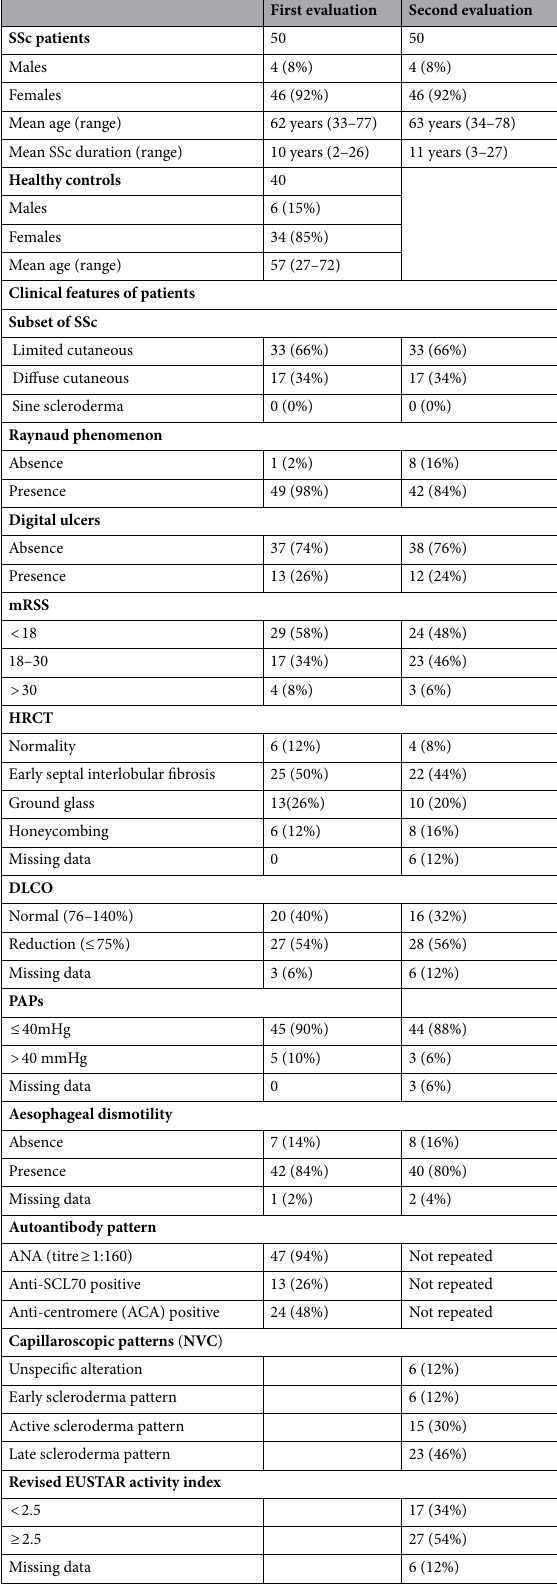
Table 3. Demographic and clinical characteristics of patients. Epidemiological and clinical features of enrolled subjects are expressed as absolute numbers and percentages. The nailfold videocapillaroscopy (NVC) and revised EUSTAR activity index were included in the second evaluation